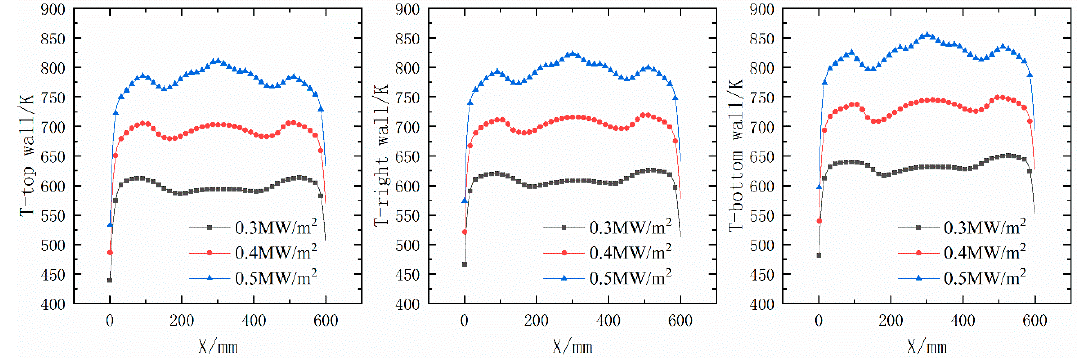
Figure 10. Comparison of wall temperature along the X-axis with different heat flux.